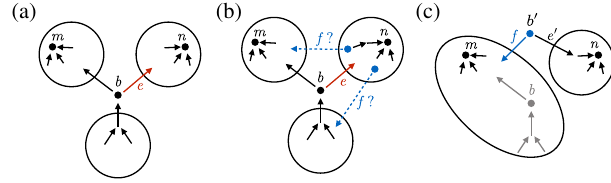
FIG. 12. Effect of edge swap on S mn;b . (a) The structure of S m , n and branch point b . mn;b , a doubly-rooted tree with roots The edge e is the unique edge pointing out of s ð e Þ ¼ b toward n . (b) Removing the edge e disconnects S mn;b , since it is a tree. The edge f from T b that reconnects it can point from the component containing n to any part of the component containing m . It is also possible that f ¼ e (cid:4) . (c) No matter where f points, removing e and adding f to S mn;b yields a new doubly-rooted tree S 0 mn;b , with 0 branch point b 0 ¼ s ð f Þ